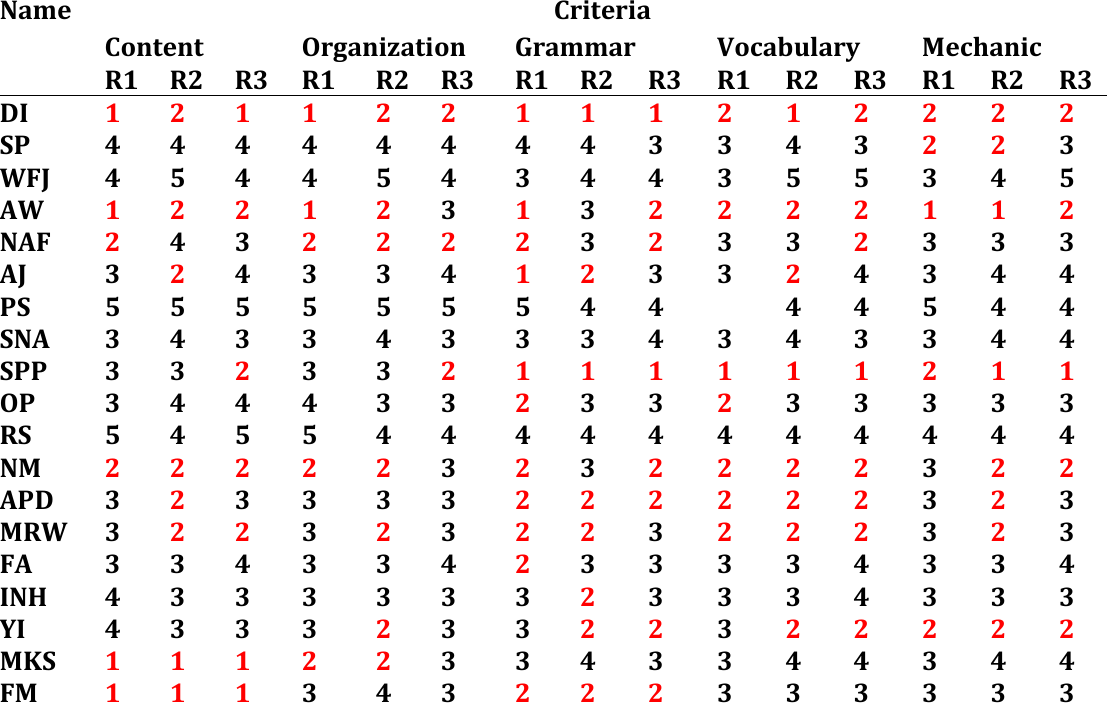
Table 2. Students’ Score of Problem in Writ ing a Personal Letter from 3